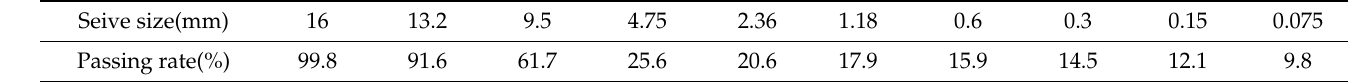
Table 5. SMA-13 gradation composition.